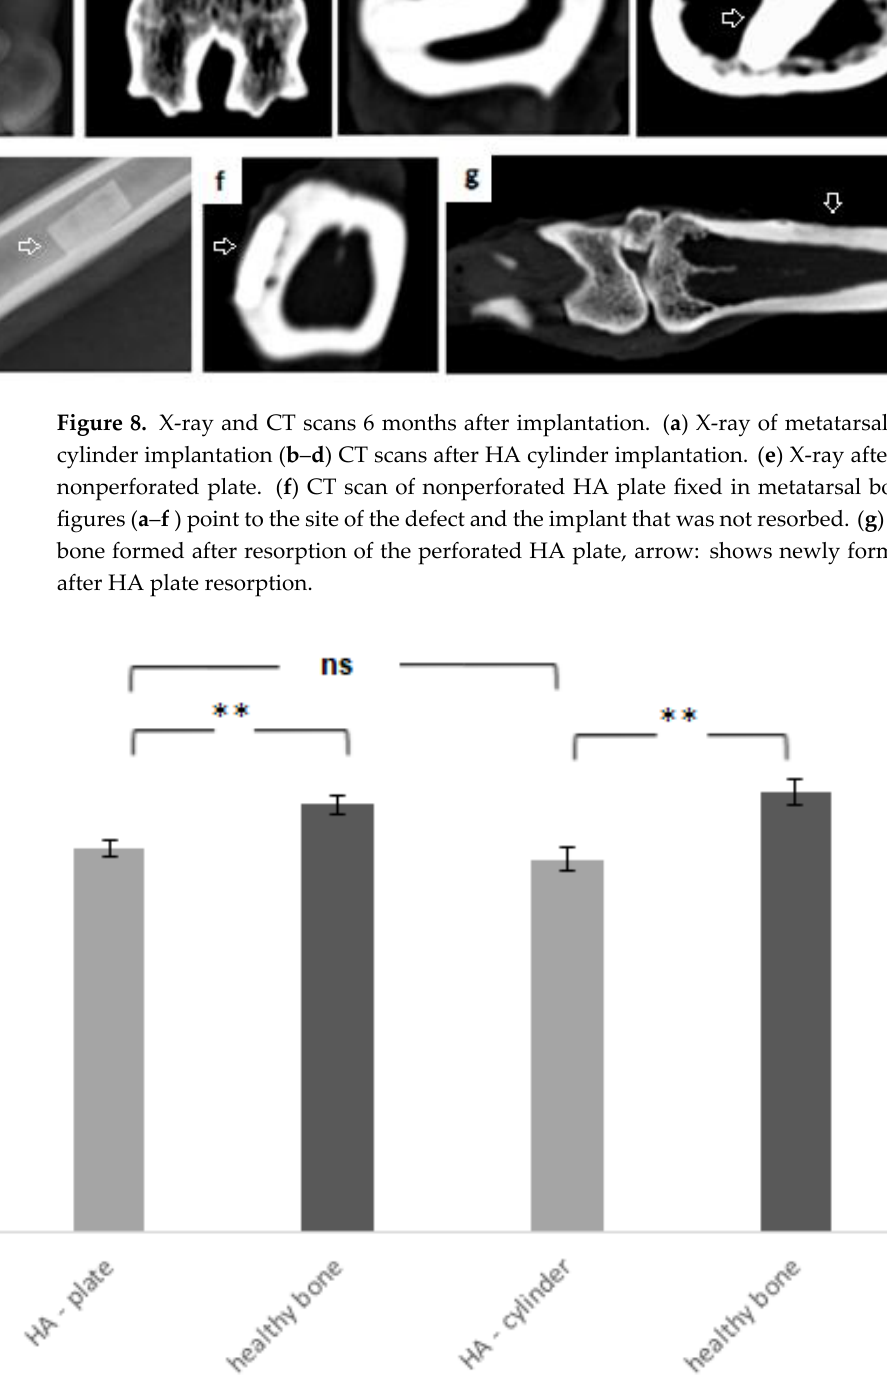
Figure 9. Bone density of newly formed bone tissue 6 months after the application of HA plate and HA cylinder was compared with the density of the adjacent healthy bone. HU — Hounsfield units. ** = p < 0.01, ns — nonsignificant = p > 0.05.